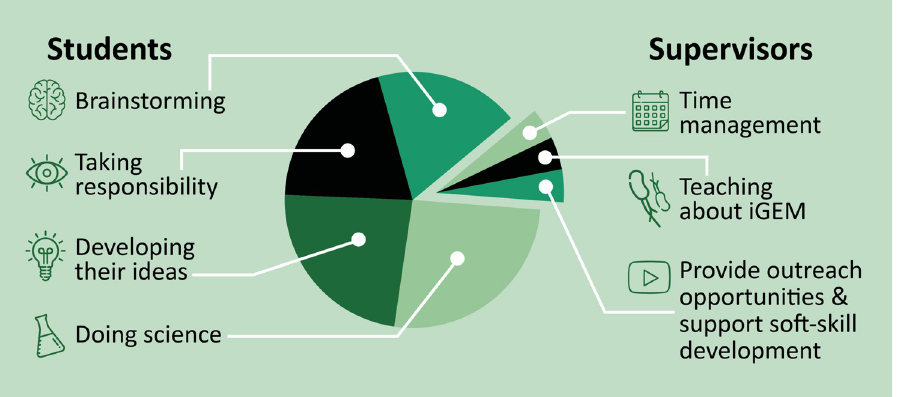
Fig 4. Task division between students and supervisors. The role of the supervision team is to coach the students to perform research. As such, much of the “heavy work” in relation to project design, conducting research, and interacting with stakeholders need to be performed by the students. Icons were made with Freepick, DinosoftLabs, Srip, and Smashicons from Flaticon. iGEM, international Genetically Engineered Machine.